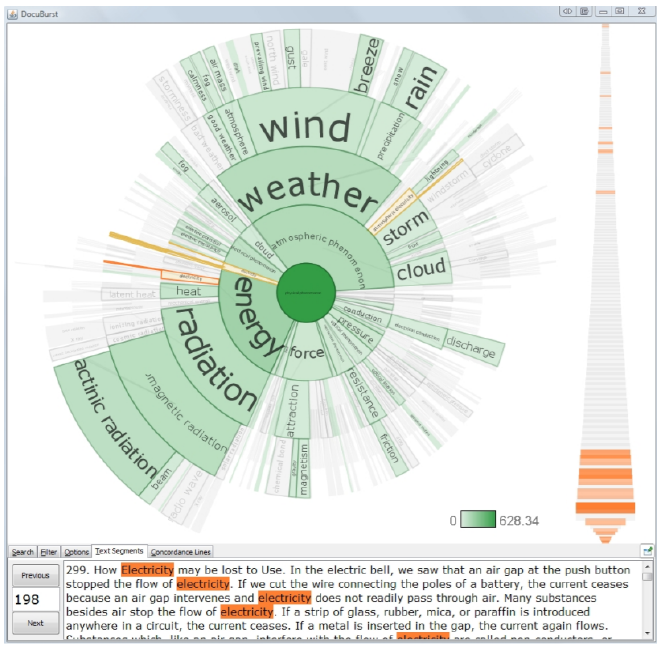
Figure 17. Rising sun diagram [64]. The document scatter is the search for “electricity” related synonym sets, the closer to the core the stronger the